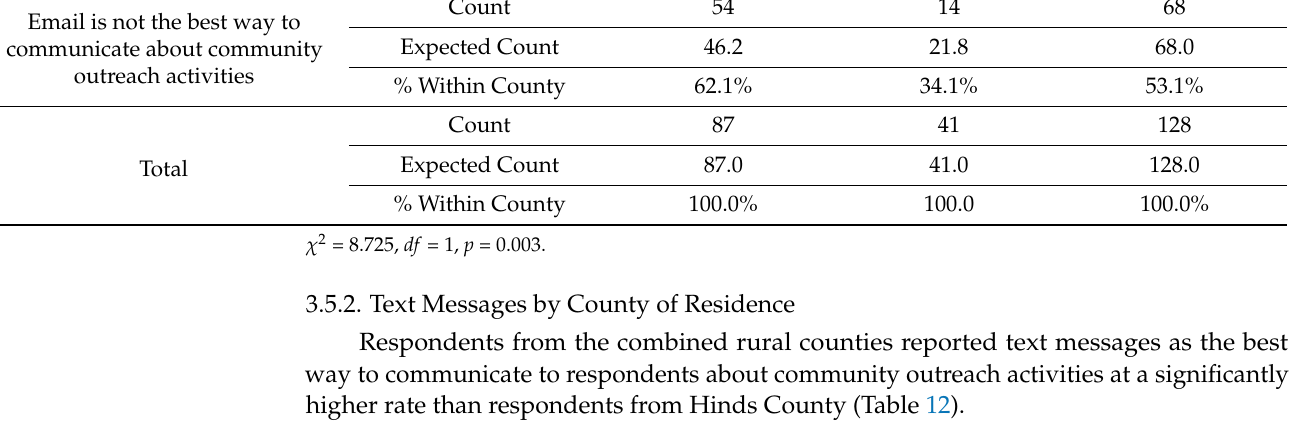
Table 12. Text Messages as the Best Way to Communicate to Respondents about Community